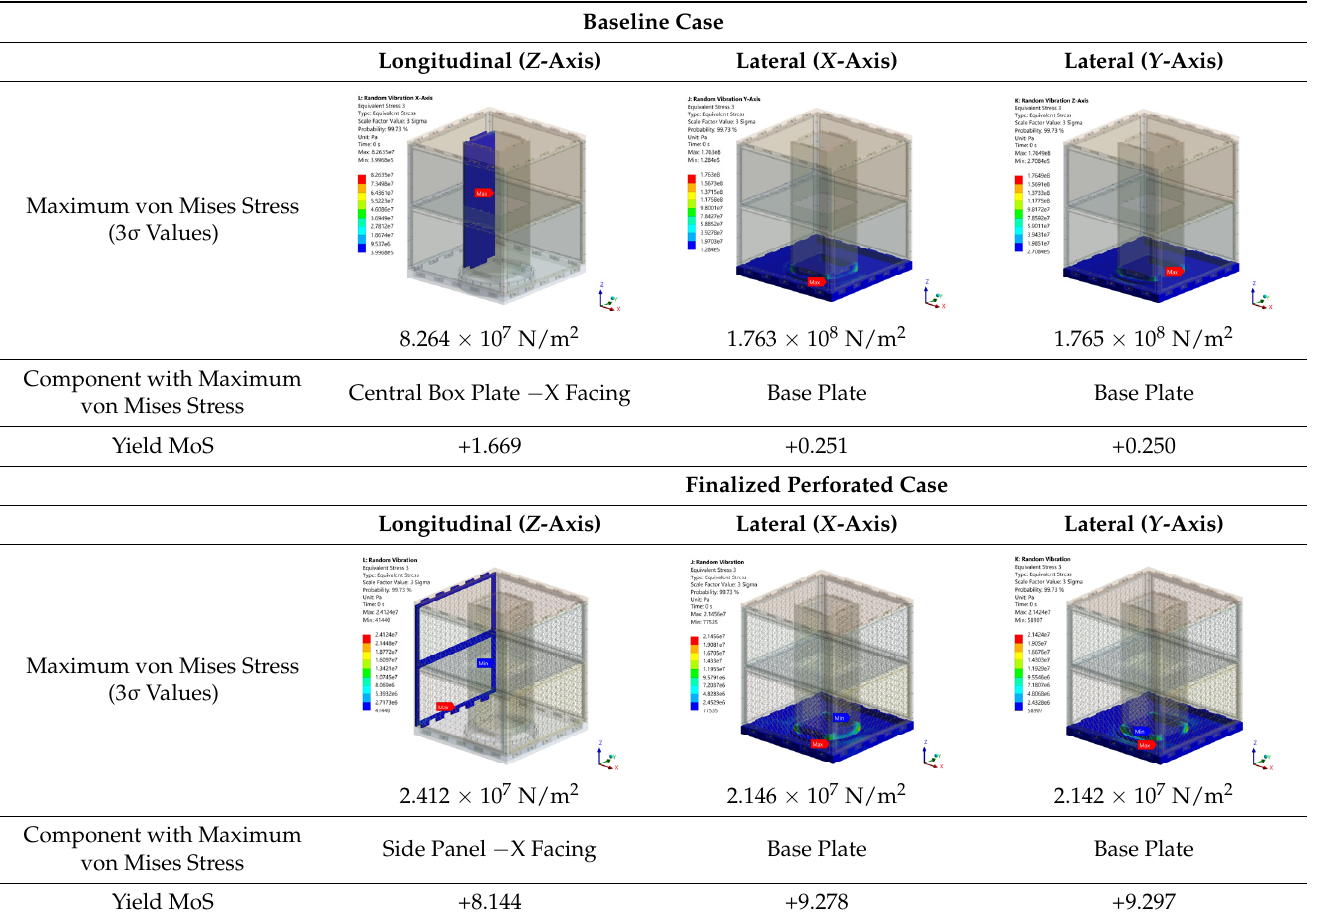
Table 6. Baseline and perforated random launch loads—maximum von Mises stresses.